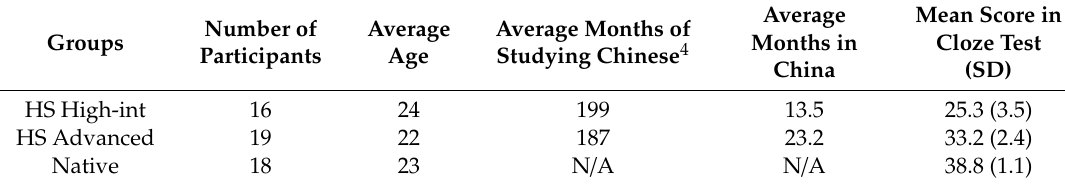
Table 1. Information about participants in each